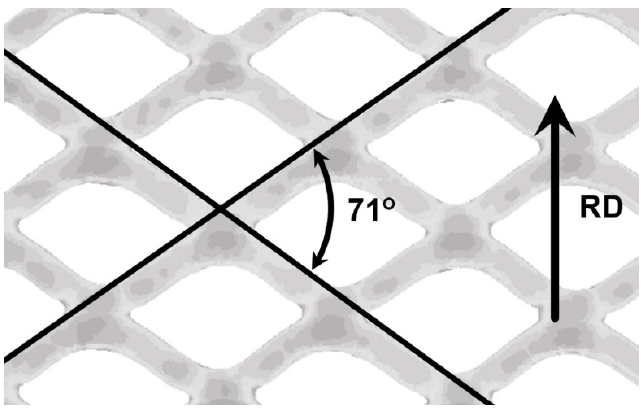
Figure 3. Example of the change of the mesh angle during roll bonding on the plane projection of the µCT-image; RD: rolling direction.